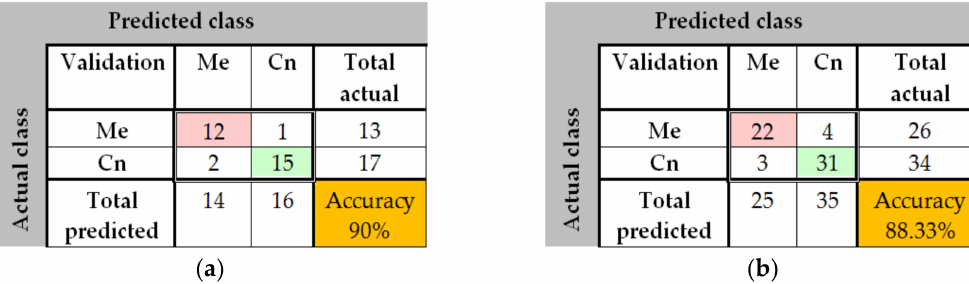
Figure 24. ( a ) Confusion matrix for validation phase in the case of ResNet-101 CNN for the PH 2 database; ( b ) Confusion matrix for validation phase in the case of ResNet-101 CNN for the ISIC 2019